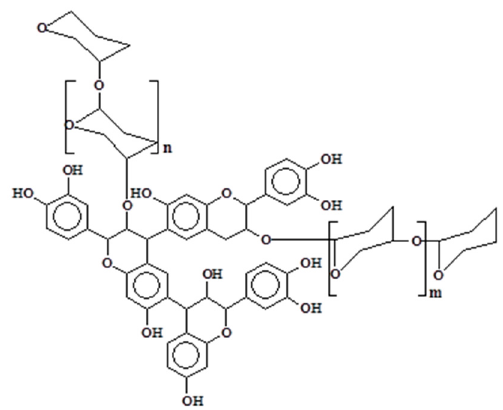
Figure 1. Polyflavonoids and carbohydrates linkage.